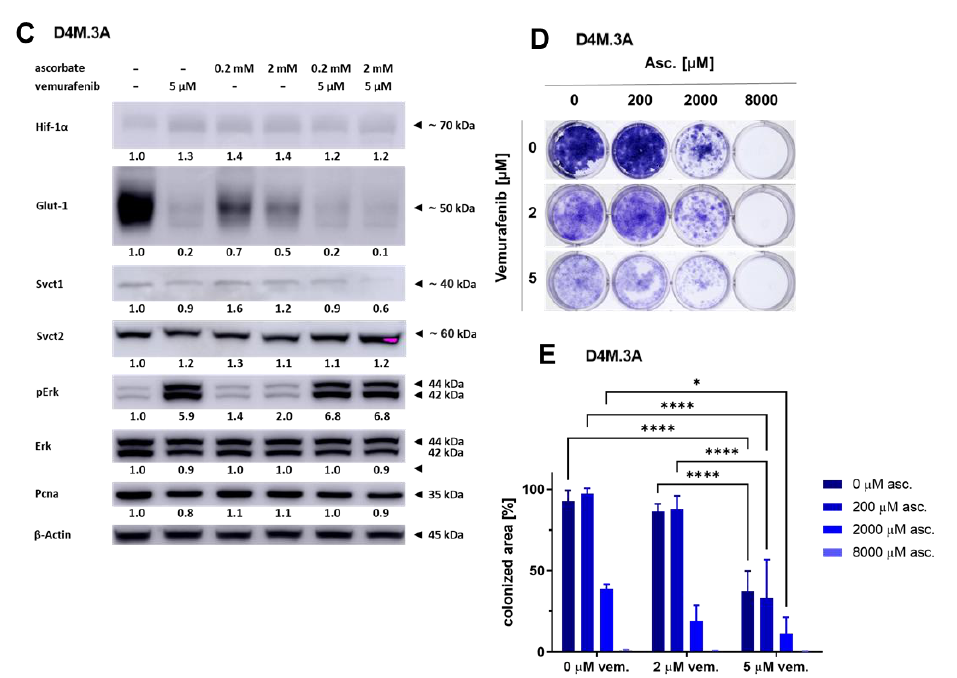
Figure 4. Effects of ascorbate and vemurafenib on viability, cell cycle, protein expression and long-term growth of BRAF mutated mouse melanoma cells D4M.3A. ( A ) D4M.3A cells were treated with ascorbate, vemurafenib, and their combination. Viability of treated cells was measured and compared to the untreated control. Shown are the mean values with standard deviations of three independent experiments, each measured in quadruplicates and normalized to the untreated control. ( B ) D4M.3A cells were treated with ascorbate, vemurafenib, and their combination. After propidium iodide staining, the cell cycle was measured by flow cytometry. Shown are the mean values of each cell cycle fraction with standard deviations of three independent experiments, each measured in triplicates. ( C ) Protein expression levels of Hif-1α, Glut-1, Svct1, Svct2, phospho-Erk1/2 (pErk), Erk1/2 (Erk), Pcna, and β-Actin as control were analyzed by Western Blot in the cell line D4M.3A after treatment with ascorbate, vemurafenib, and their combination. Shown is one representative experiment of three. ( D ) For a colony formation assay D4M.3A cells were treated with ascorbate, vemurafenib and the combination. The growth area of the formed colonies was measured and normalized to the surface area of the culture dish (100%). ( E ) Quantification of the colony formation assay shown in ( D ). D4M.3A cells were treated with ascorbate, vemurafenib and the combination. *: p ≤ 0.05; ****: p ≤ 0.0001.